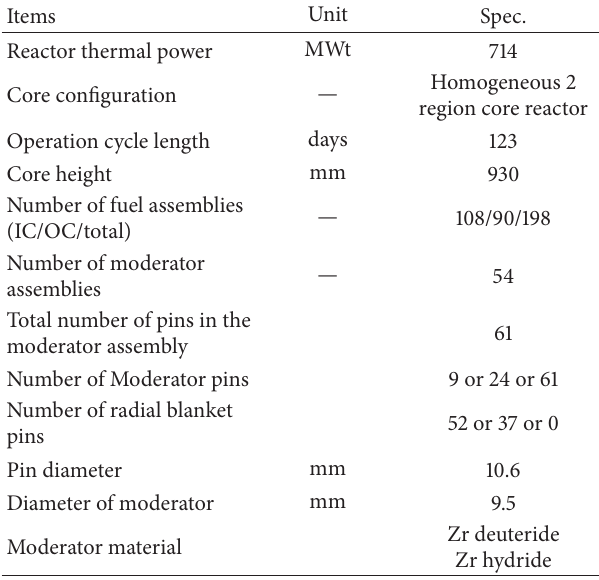
Table 1: Specification of MONJU